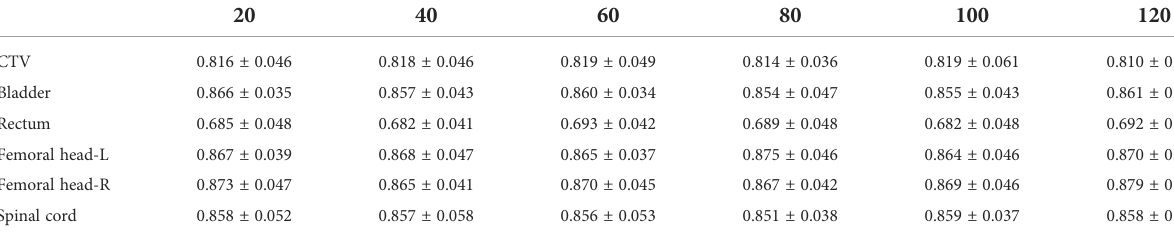
TABLE 3 The DSC value of CTV and OARs in different atlas library groups (mean ±